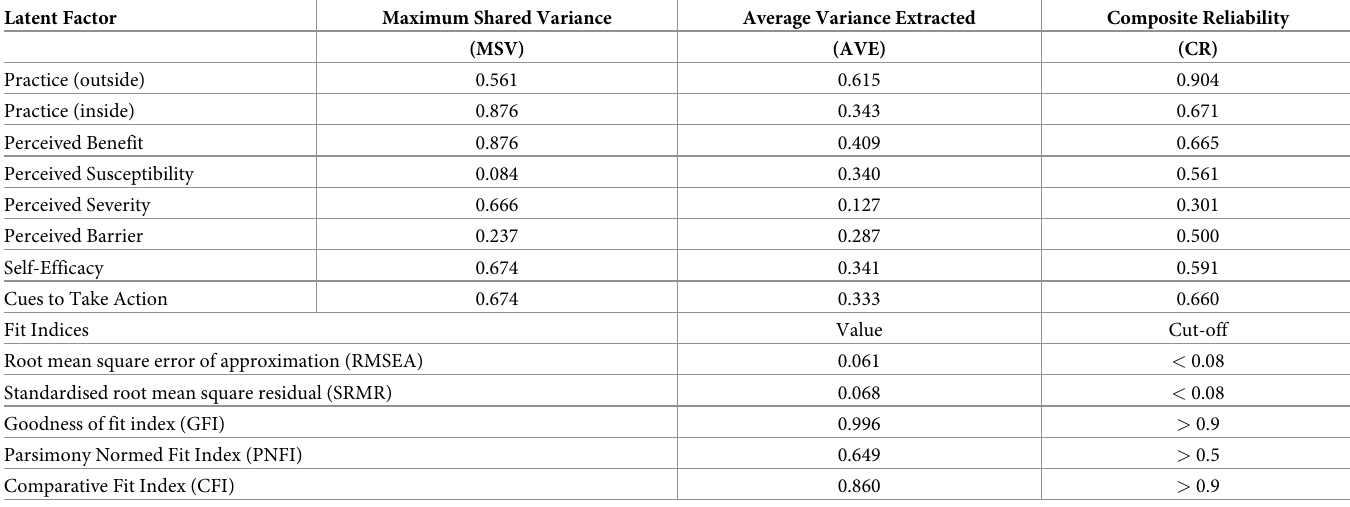
Fig 1. Path analysis of the confirmatory factor analysis (CFA) showing standardised estimates of the correlations (figures on the arrows) between the five domains (ellipse), the 31 items (rectangle). (P.Sev = Perceived Severity; P.Bar = Perceived Barrier; SE = Self-Efficacy; CTA = Cues-to-action; P.Sus = Perceived Susceptibility; P.Ben = Perceived Benefit; Pr-In = Practice Inside the housing compoung; Pr-Ot = Practice Outside the house compound namely the neighbourhood). https://doi.org/10.1371/journal.pone.0256636.g001 Table 4. Result of MSV, AVE, CR, and fitness of the model obtained from